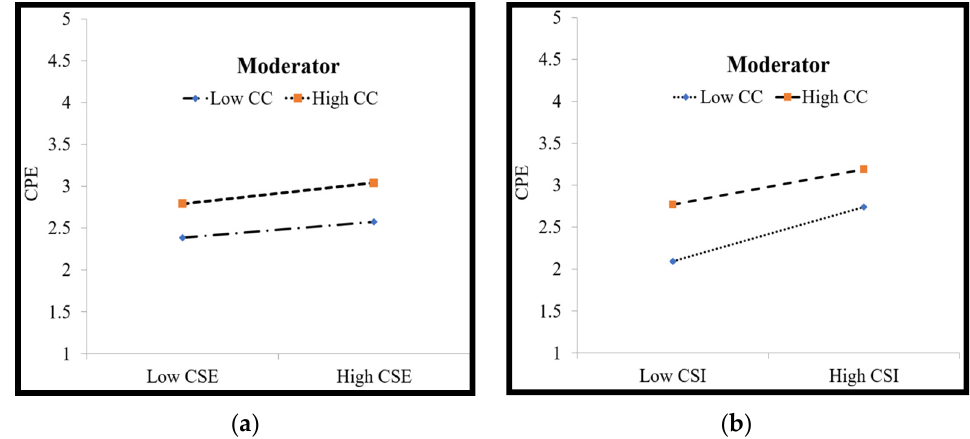
Figure 3. ( a ) Moderation effect of CPE on CSE-CPE; ( b ) Moderation effect of CPE on CSI-CPE.